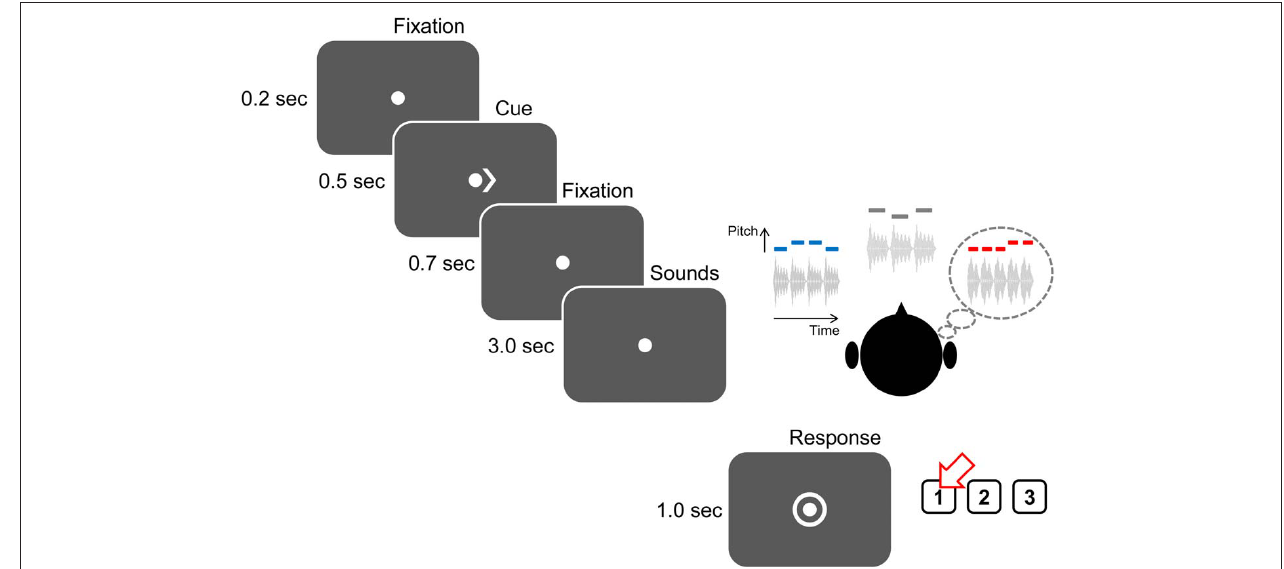
700-ms-long gap before the sound (and, on attend-visual trials, arrow) streams begin to play. After the end of the streams, listeners have 1s during which a circle surrounds the fixation point, instructing listeners to identify the kind of contour (“1” for ascending, as in the above example; “2” for descending; and “3” for